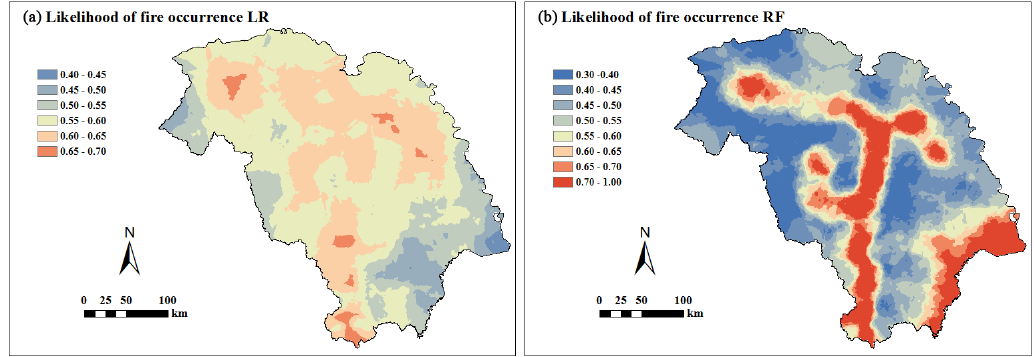
Figure 6. Likelihood of fire occurrence created using the Kriging method with ArcGIS based on predicted values using Logistic Regression ( a ) and Random Forests ( b ) models.